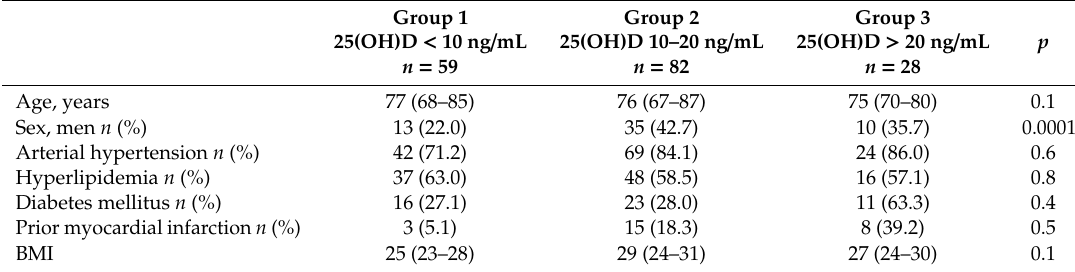
Table 1. Baseline clinical characteristics. Values are presented as medians (interquartile range) or n